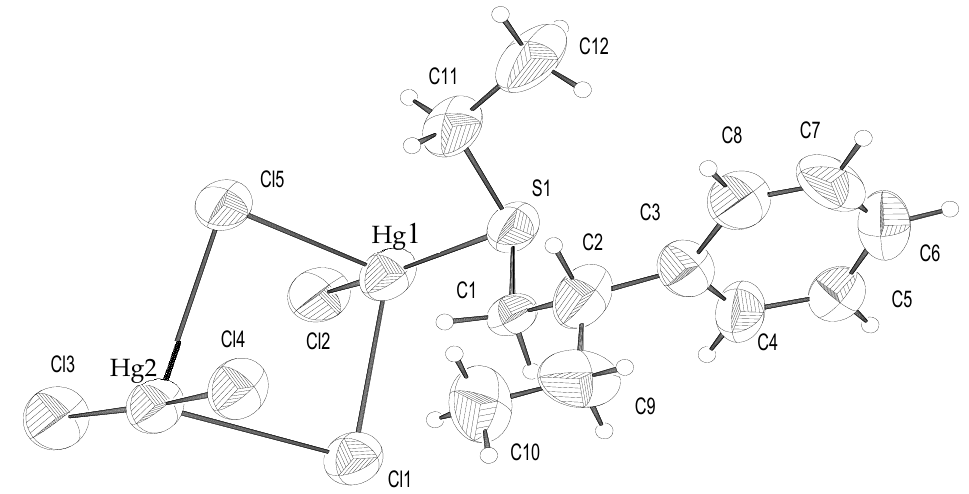
Figure 1. Asymmetric unit and labelling of the crystal structure of compound ( II ). Thermal ellipsoids are at the 50% probability level.